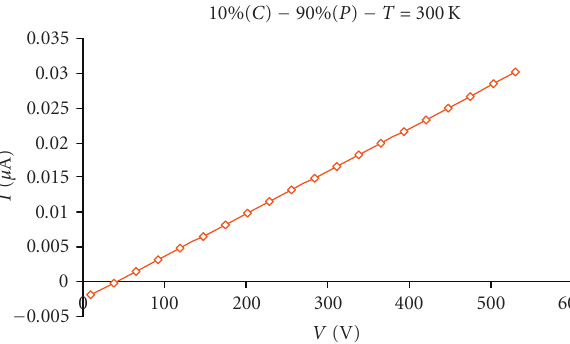
Figure 2: The I-V characteristic for sample no.1 at room tempera- ture.